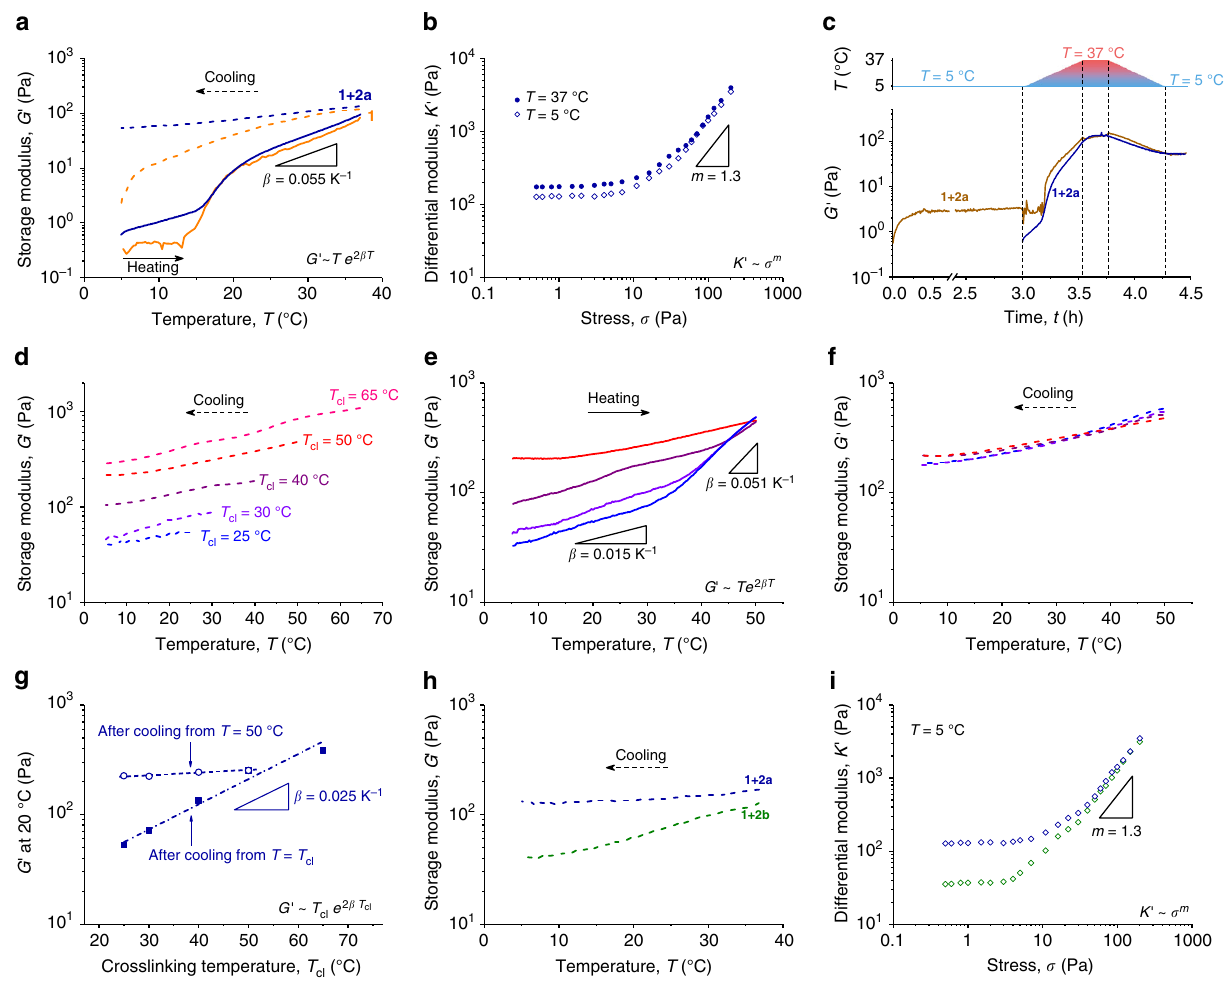
Fig. 2 Mechanical properties of intra-bundle crosslinked PIC hydrogels. a Storage modulus G ′ of a crosslinked ( 1 + 2a , blue data) and a not-crosslinked (only 1 , orange data) PIC gel. The heating (solid lines) curves shows gel formation at 15 – 20 °C. After crosslinking at 37 °C, the cooling (dashed lines) curve of 1 shows ‘ melting ’ , while 1 + 2a remains a gel. The thermal stiffening exponent β originates from single chain stiffening 14 . b Strain-stiffening: differential modulus K ′ = ∂ σ / ∂ γ as a function of applied stress σ for the 1 + 2a gel (crosslinked at T cl = 37 °C) and measured at 5 °C (open diamonds) and 37 °C (solid circles). Below a critical stress σ c , K ′ = G ′ , above it K ′ ~ σ m , with m the stiffening index, quantifying the responsiveness to stress. c Crosslinking in the absence of bundles (at T cl = 5 °C, light blue data) does not lead to network formation, but as soon as the temperature is raised and bundles form, the gel forms permanent crosslinks that are stable on cooling, similar to that of the immediately crosslinked sample (blue data). d Storage moduli G ′ of 1 + 2a gels crosslinked at T cl = 25 °C (blue), T cl = 30 °C (violet), T cl = 40 °C (purple), T cl = 50 °C (red) and T cl = 65 °C (pink) when cooling from the crosslinking temperature T cl to 5 °C (cooling rate: 1 °C min – 1 ). e G ′ of crosslinked PIC gels ( T cl = 25 – 50 °C), reheating from 5 °C to 50 °C with a heating rate of 1 °C min – 1 . f The moduli of crosslinked PIC gels ( T cl = 25 – 50 °C), cooling from 50 °C to 5 °C with a heating rate of 1 °C min − 1 fully overlap. g The moduli of crosslinked gels at T = 20 °C, measured after cooling from their respective crosslinking temperature (red data) and after cooling from T = 50 °C (black data). h Effect of the length of the crosslinker: G ′ of gels crosslinked with a ‘ long ’ crosslinker 2b (green) and ‘ short ’ crosslinker 2a (blue); both cooling from T = 37 °C to 5 °C ( − 1 °C min – 1 ). i Differential modulus of the hydrogels crosslinked with the ‘ long ’ ( 2b , green) and the ‘ short ’ ( 2a , blue) spacer, cl crosslinked at T cl = 37 °C and measured at T = 5 °C. For all experiments in Fig. 2, the concentrations were identical: [ 1 ] = 1 mg mL − 1 , equivalent to [N 3 ] = 104 µ M; crosslinkers: [ 2a ] or [ 2b ] = 52 µ M (or 0 µ M in panel a